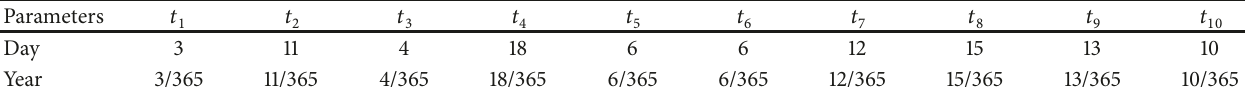
Table 2: The values for 𝑡 𝑖 .